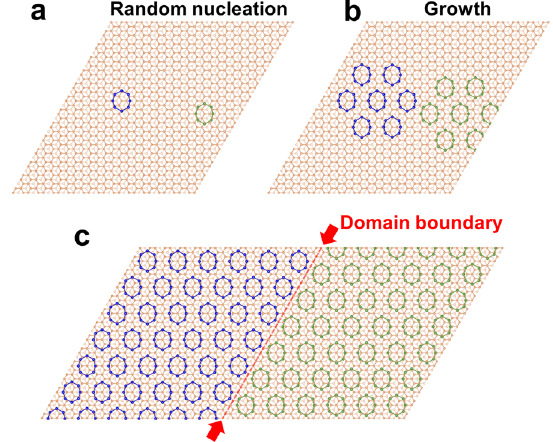
Fig. 5 Growth and domain formation. a Random adsorption of Se 8 molecules on energetically equivalent sites on the BLG surface to form nuclei for growth. b Growth of 2